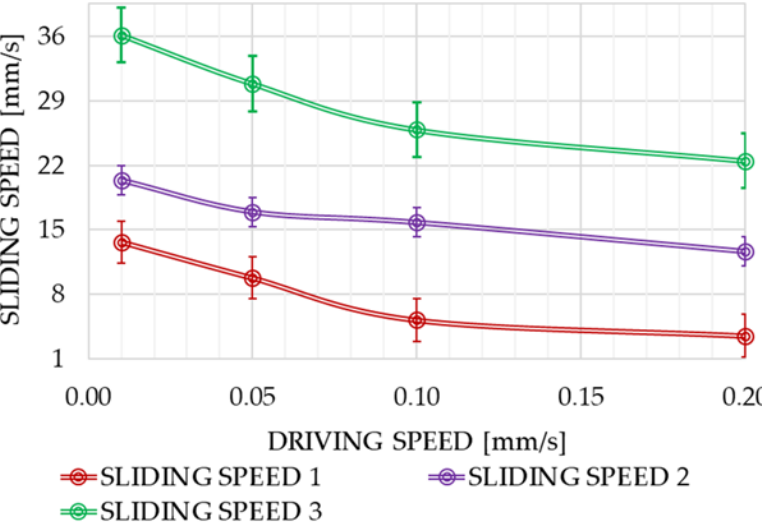
Figure 4. Variation in sliding speed with driving speeds (mm/s), including error bar.